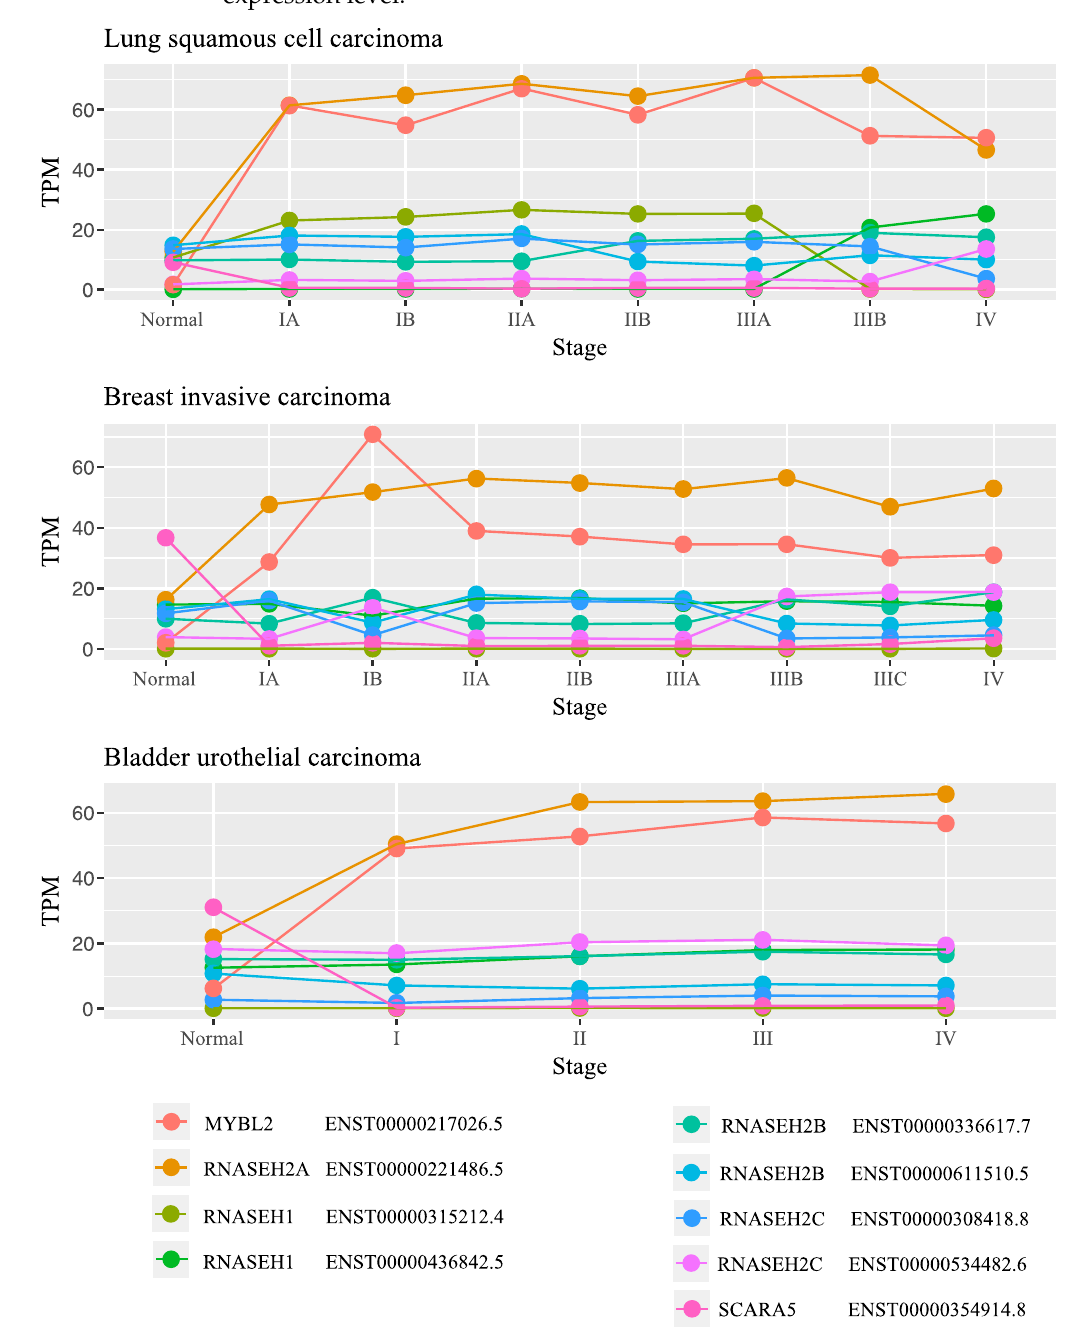
Figure 3. RNASEH2A levels in normal and at different stages of lung squamous cell carcinoma, breast invasive carcinoma, bladder urothelial carcinoma (top to bottom, respectively). Expression levels of different transcripts of RNASEH genes, including MYBL2 and SCARA5 , were examined in in TPM.